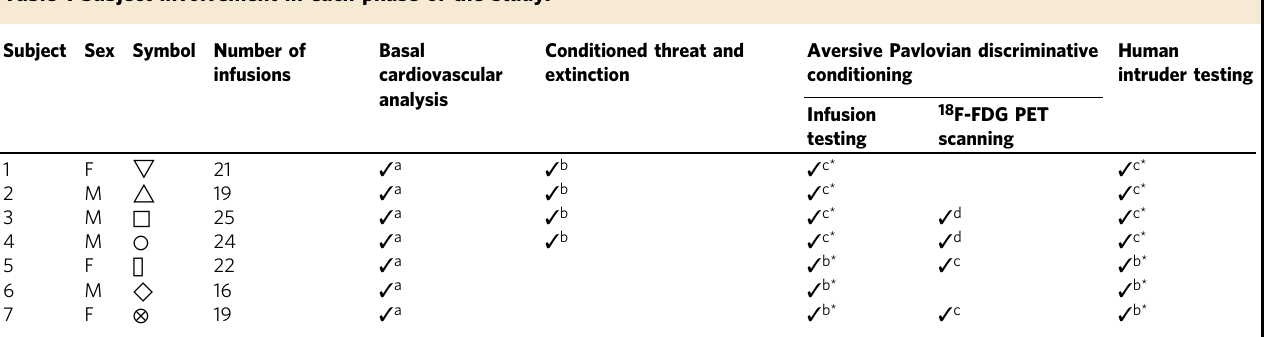
Table 1 Subject involvement in each phase of the study.